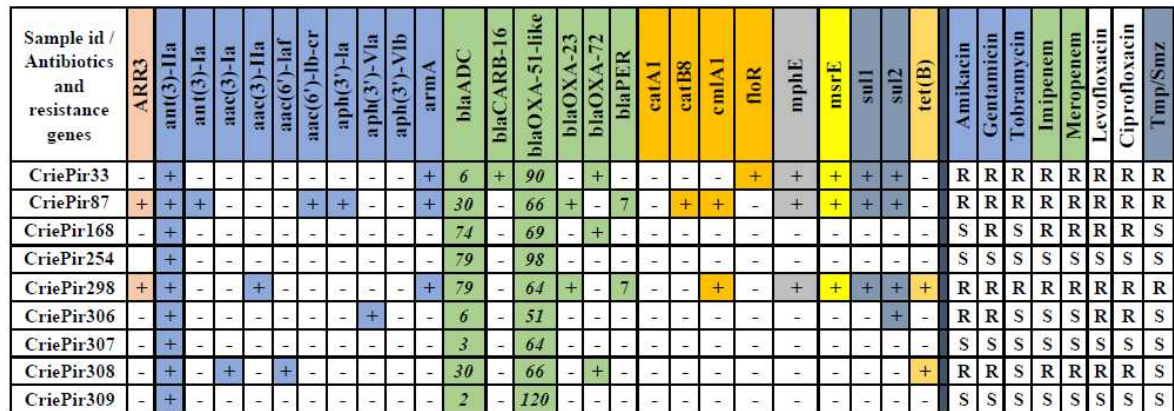
Figure 2. Antimicrobial resistance of the A. baumannii isolates studied. Corresponding antibiotics and resistance genes are filled with the same colors. The numbers for the bla genes indicate the corresponding variants for the sake of brevity. Tmp/Smz—trimethoprim/sulfamethoxazole.